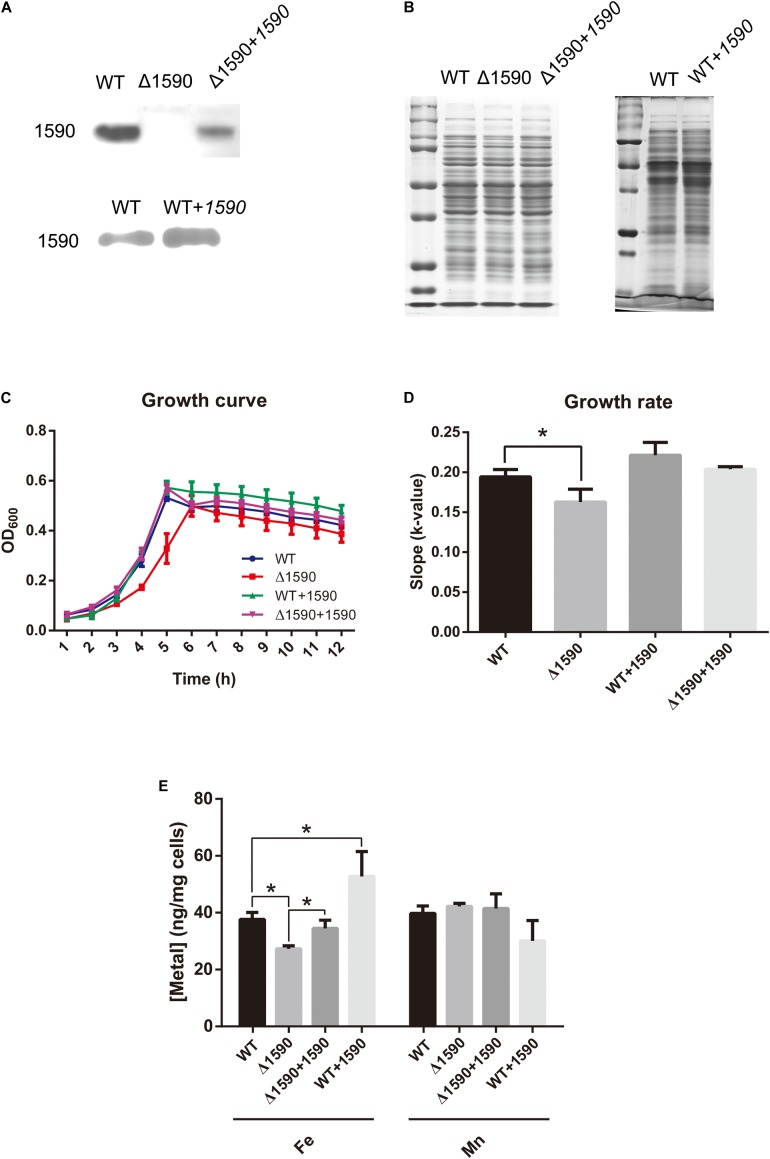
The deletion of spd1590 affects bacterial growth and iron uptake. (A) The expression of SPD_1590 in WT, Δ1590, Δ1590+1590, and WT+1590 strains as detected by western blotting. (B) SDS-PAGE of total proteins used as loading control for the western blotting experiments of A. The left one corresponds to the upper panel of A and the right one corresponds to the lower one. (C) The growth curves of WT, Δ1590, Δ1590+1590, and WT+1590 strains cultured in C+Y medium. (D) The growth rates of WT and mutant D39 strains as per the growth curves in C. (E) The iron and manganese contents in WT, Δ1590, Δ1590+1590, and WT+1590 strains as analyzed by ICP-MS (∗p < 0.05).